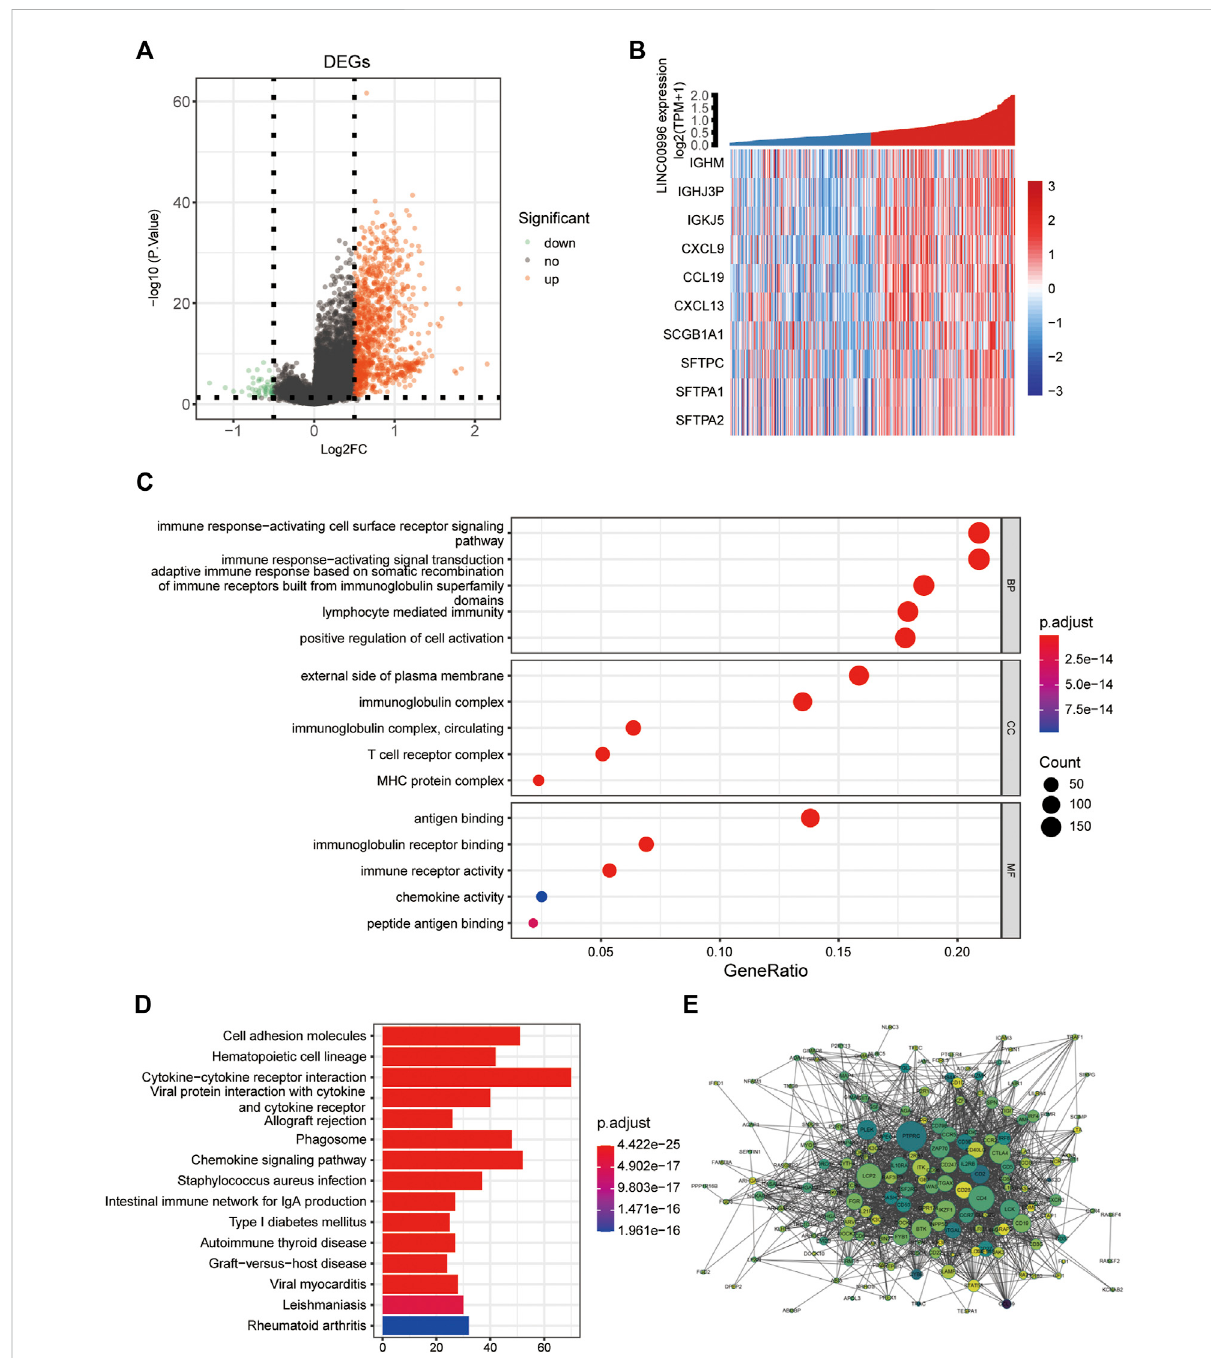
FIGURE 4 (A) Linc00996 high- and low-expression groups, volcano plot of differentially expressed genes. (B) Linc00996 high- and low-expression groups, differentially expressed gene heatmap. (C,D) Enrichment analysis of DEQSCGs. (E) DEG enrichment analysis of the PPI network (color represents logFC, darker indicates larger logFC, and all logFC is greater than 0.5; the size represents the degree of connectivity, and the larger the value is, the higher the degree of connectivity